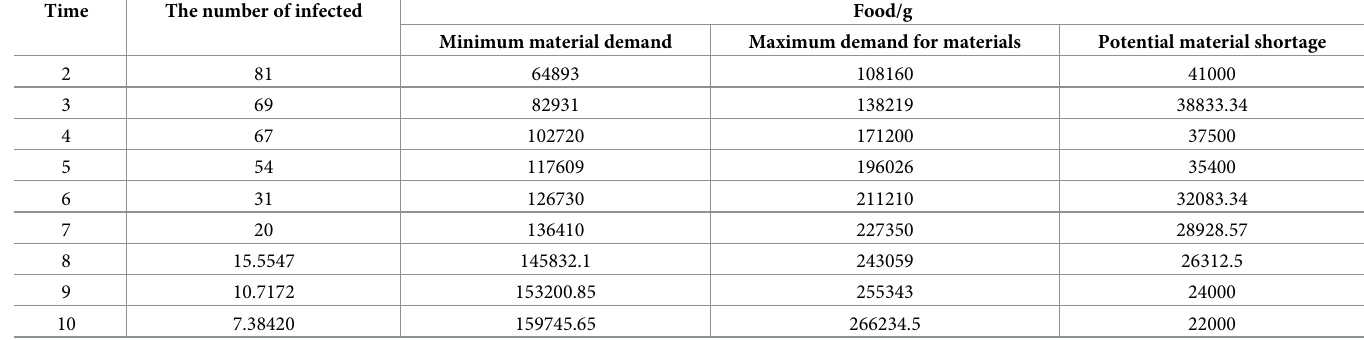
Table 7. Estimates of material